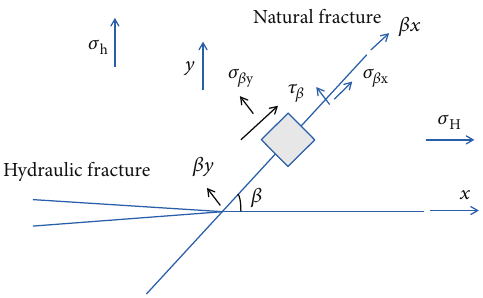
Figure 1: Fluid region boundary.